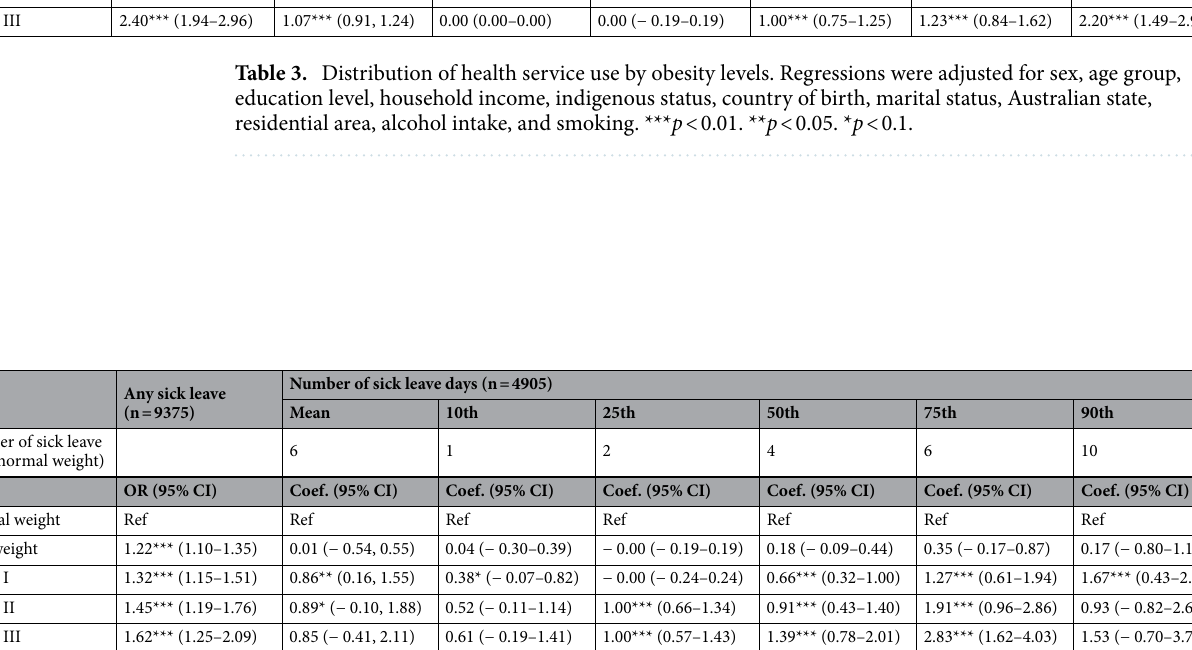
Table 4. Distribution of sick leave days by obesity levels. Regressions were adjusted for sex, age group, education level, household income, indigenous status, country of birth, marital status, Australian